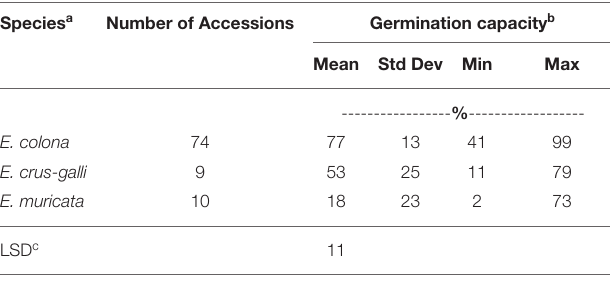
TABLE 3 | Germination capacity of Echinochloa species from Arkansas, USA, grown in a common garden at the Milo Shult Agricultural Research and Extension Center, Fayetteville, AR, averaged by species across 2 years (2012 and 2013).